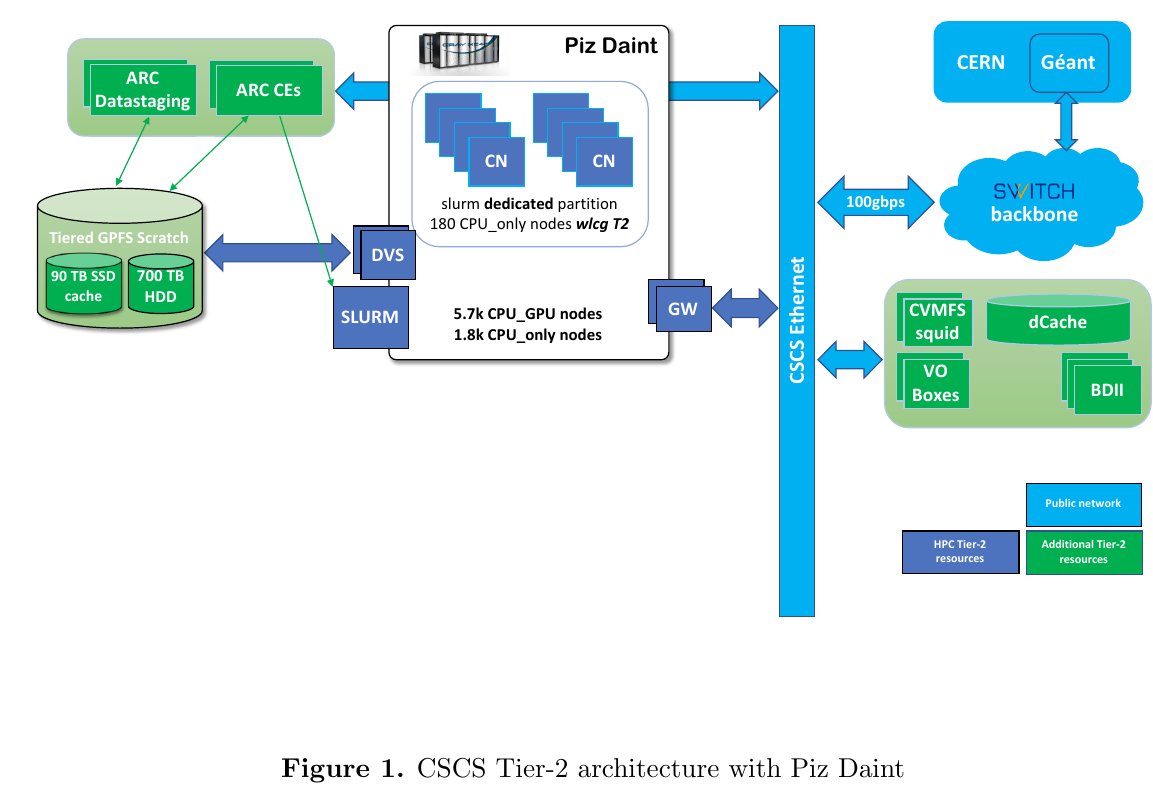
Figure 1. CSCS Tier-2 architecture with Piz